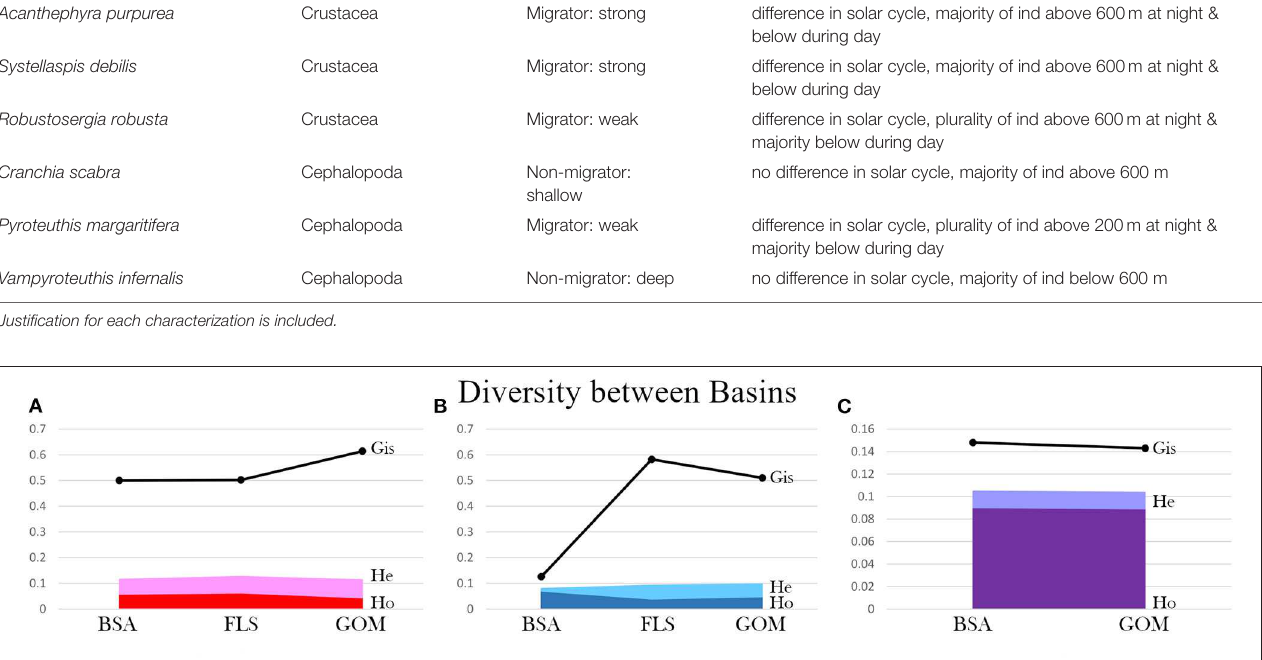
FIGURE 4 | Diversity metrics (observed heterozygosity Ho, expected heterozygosity He, and inbreeding coefficient Gis) are compared between collection localities: Bear Seamount in the Atlantic (BSA), Florida Straits (FLS), and the Gulf of Mexico (GOM) for (A) Acanthephyra purpurea , (B) Systellaspis debilis , and (C) Robustosergia robusta (note the change in y-axis